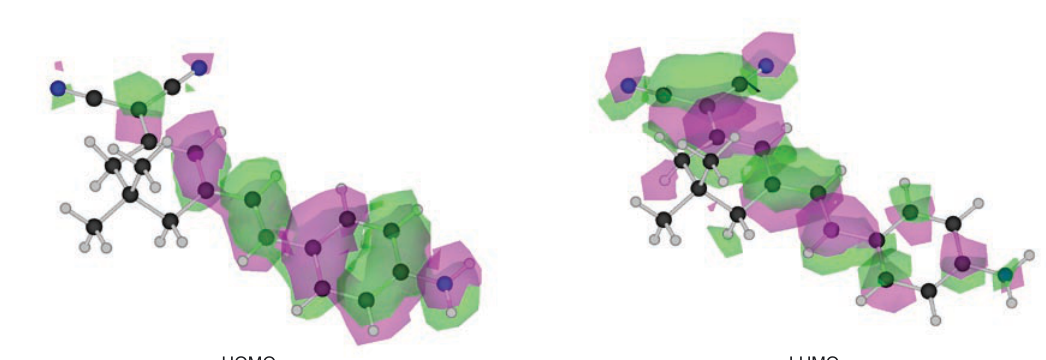
HOMO LUMO Scheme 4. Molecular orbital surface of the HOMO and LUMO for the ground